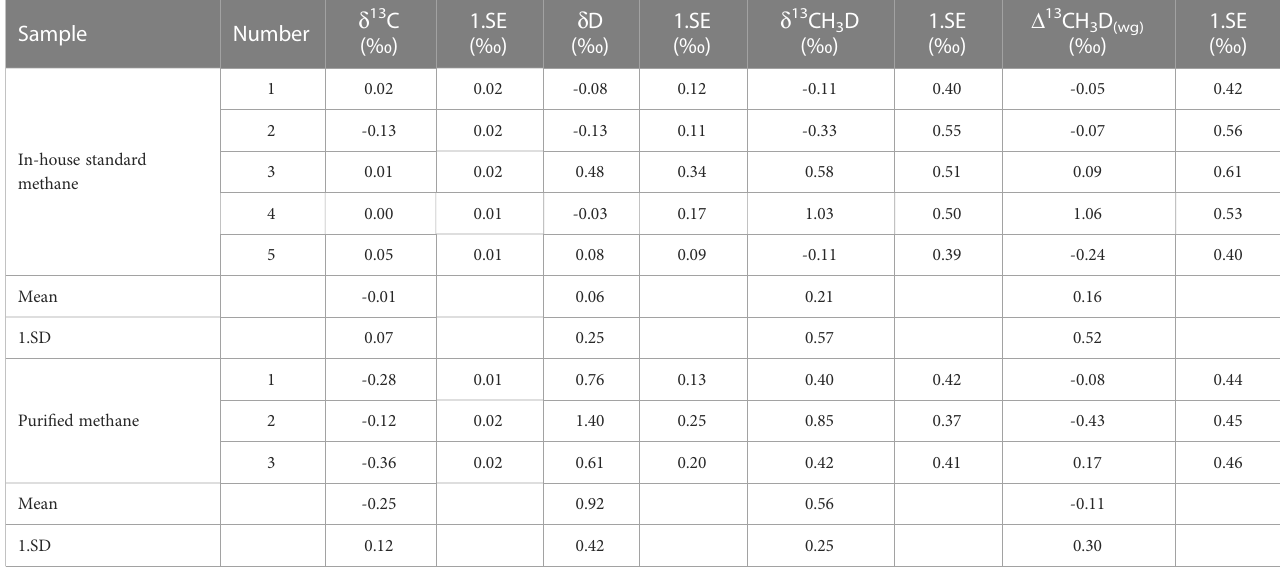
TABLE 9 Measurements of in-house standard methane and puri fi ed methane on clumped isotope determination by Ultra.